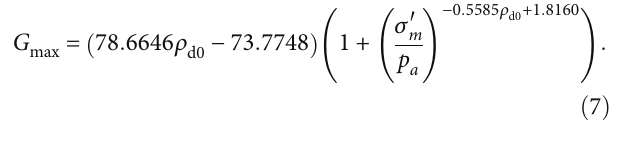
− σ ′ curves for remodeled samples at di ff erent initial dry densities; (b) variation of G Figure 8: (a) G max remolded